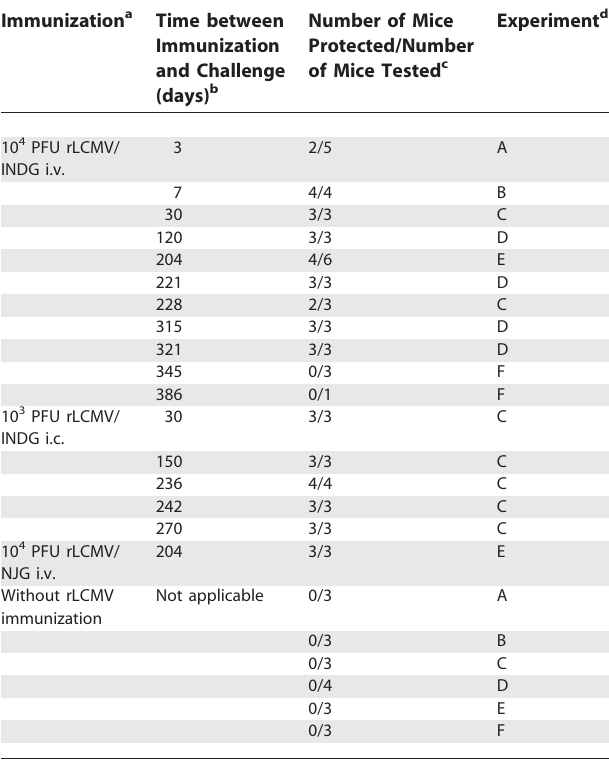
Table 2. Recombinant LCM Viruses Induce Rapid and Long- Lasting Protection against Lethal Choriomeningitis Immunization a Time